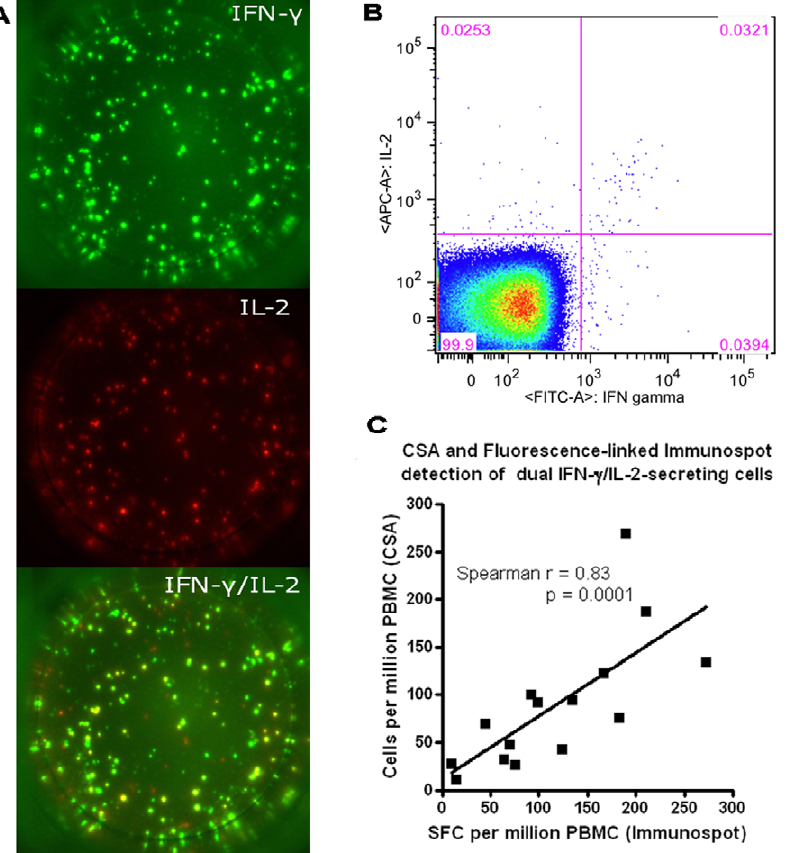
Figure 3. Comparison of the number of dual IFN- c /IL-2 –secreting cells detected by cytokine secretion assay (CSA) and fluorescence-immunospot. PBMC from 15 healthy BCG-vaccinated volunteers were stimulated with PPD and IFN- c –secreting, Il-2-secreting and dual IFN- c /IL-2–secreting cells were enumerated by CSA (gating on CD3 + lymphocytes) and fluorescence-immunospot. Fluorescence-immunospot IL- 2, IFN- c and digitally-overlaid dual images from a representative donor are shown in A with CSA results from the same donor shown with percentage of cells stated in each quadrant shown in B. Correlation between the numbers of dual IFN- c /IL-2-secreting cells detected by the 2 tests was tested by Spearman’s rank correlation